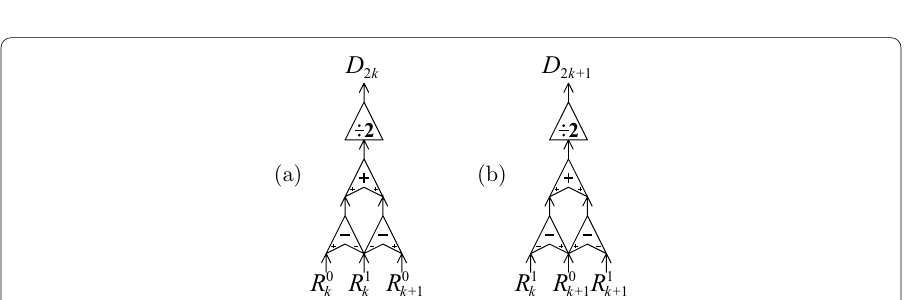
Fig. 3 In each of these subfigures, the operation indicated by “ + ” sums its two inputs and the operations indicated by “ ” subtract their inputs, with one of these “ ” operations subtracting its rightmost input − − from its leftmost input, while the other subtracts its leftmost input from its rightmost input. In all cases, the operations indicated by “ ” subtract subpopulation 1 from subpopulation 0, in that order. The operation − indicated by “ ÷ 2 ” divides its input by 2. These subfigures depict visually Formulaes (1) and (2),